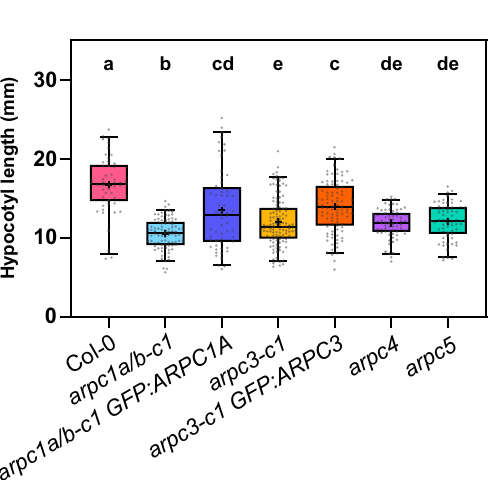
Figure 3. Pavement cell analysis of 14-day-old seedling cotyledons. ( A ) Exemplary images of the maximum projection of z-stacks around pavement cells’ middle plane. Orange arrows indicate gaps between cells. ( B , C ) Quantification of epidermal cell circularity and area for Col-0 and mutants lacking single ARP2/3 complex subunits ( arpc1a/b-c1 , arpc3-c1 , arpc4 , arpc5 ). Statistical analysis was performed fitting a linear mixed model on squared root-transformed data followed by a posthoc Tukey HSD multiple comparison test. n = 137–226 cells. Different letters denote statistical significance ( p < 0.05). ( D , E ) Quantification of epidermal cell circularity and area for Col-0, arpc1a/b-c1, and its corresponding rescue line. Statistical analysis was performed fitting a linear mixed model on either log- or squared root-transformed data (circularity and area, respectively) followed by posthoc Tukey contrasts. Different letters denote statistical significance ( p < 0.05). n = 191–263 cells.